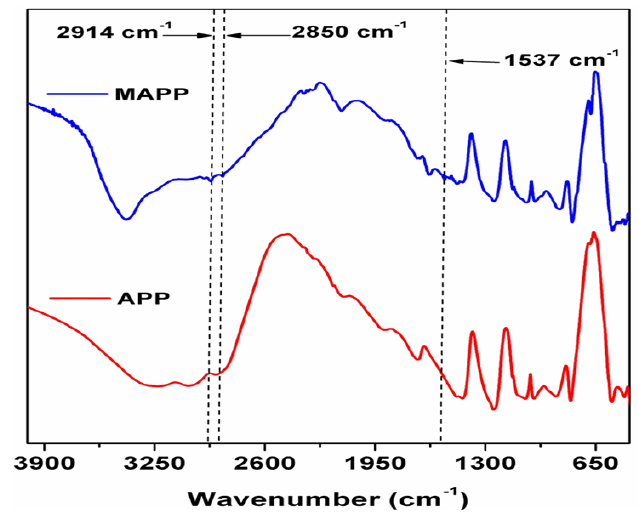
Figure 1. FT-IR spectra of Modified Ammonium polyphosphate (MAPP) and Ammonium polyphosphate (APP).